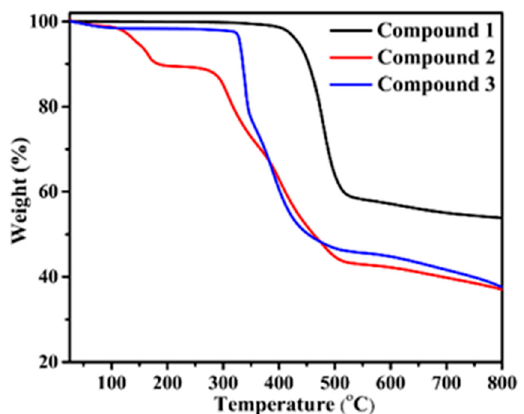
Figure 5. Thermogravimetric curves of the three compounds.